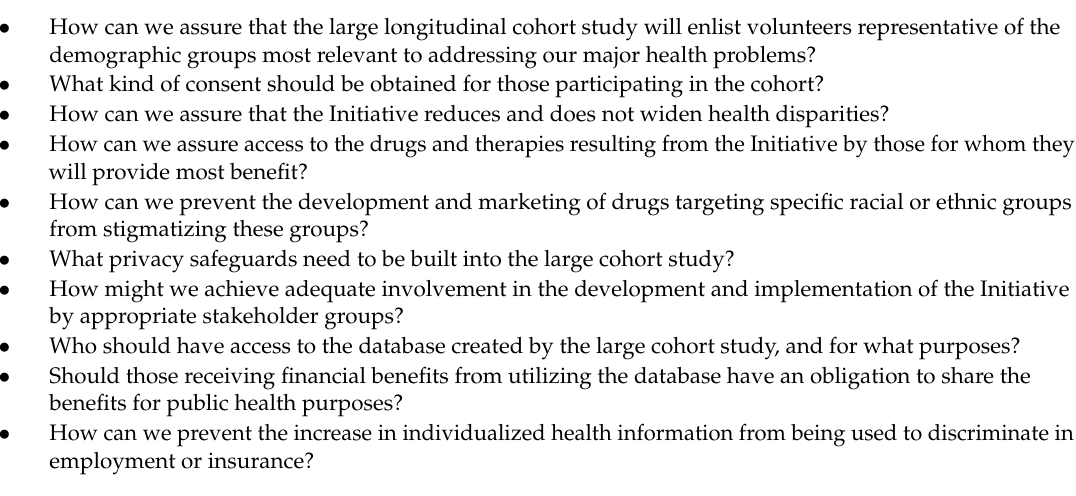
Table 1. Questions posed to students for the precision medicine and public health class